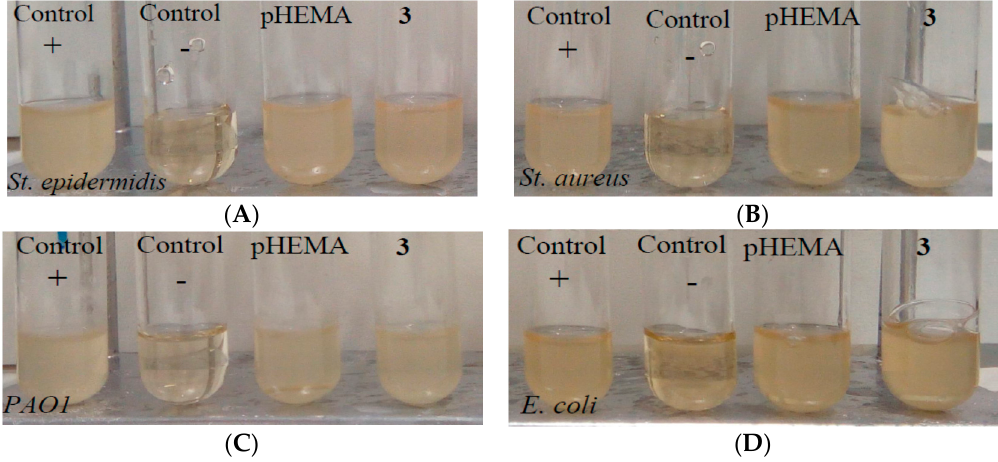
Figure 8. Bacteria viability St. epidermidis ( A ), St. aureus ( B ), PAO1 ( C ) and E. coli ( D )) upon their incubations above discs of pHEMA or 3.